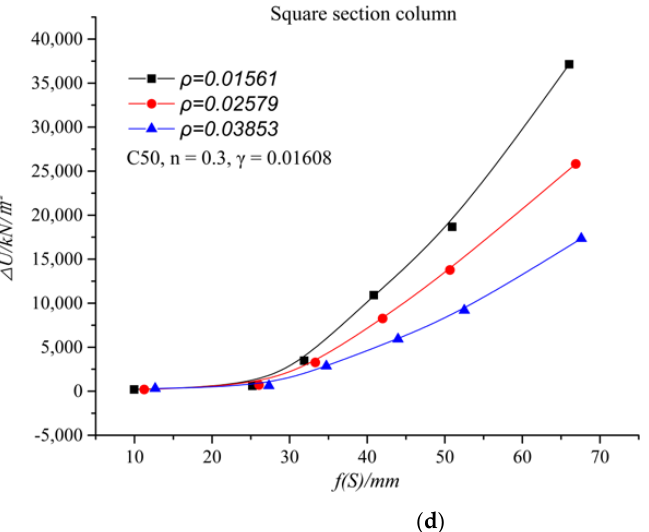
Figure 6. The relation between the unit energy dissipation and maximum stress f(S) of the FRP- confined columns: ( a ) circular section ( ρ = 0.02667, n = 0.3, γ = 0.00907); ( b ) circular section (C40, n = 0.2, γ = 0.0136); ( c ) rectangular section ( ρ = 0.015603, n = 0.3, γ = 0.016081); and ( d ) rectangular section (C50, n = 0.3, γ = 0.01608). After the above calculation and analysis, the formulas of the energy dissipation per unit volume of FRP-C RC circular columns and square columns considering bond-slip- page can be obtained, as shown in the following Equations (17) and (18).